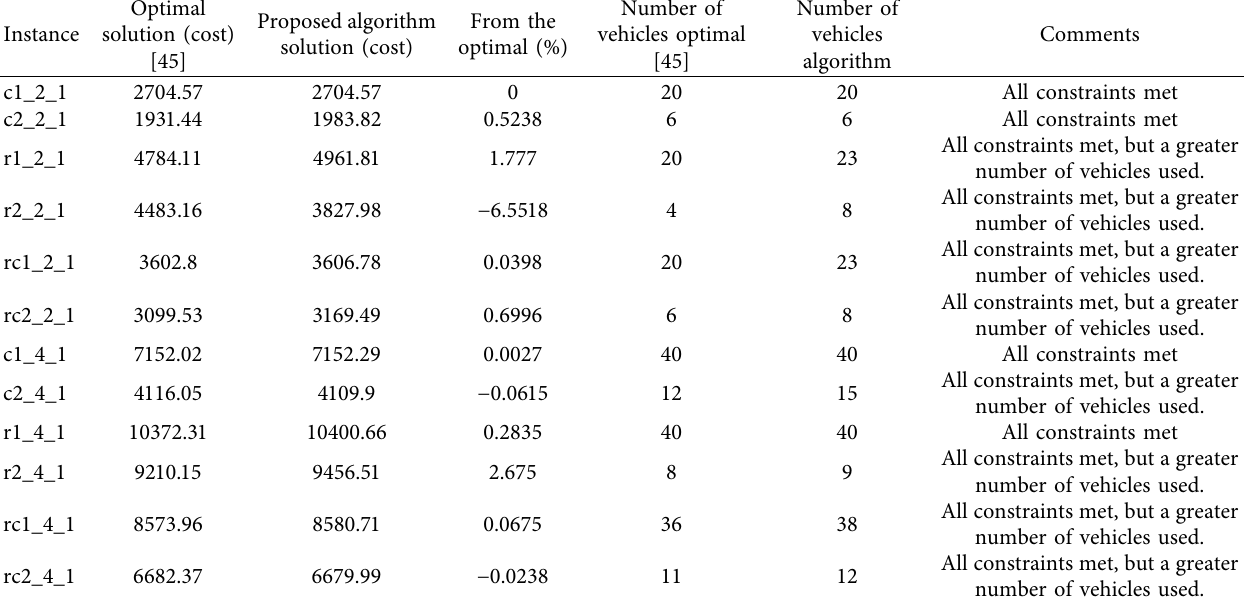
Table 2: Results of testing on instances for 200 and 400 customers.